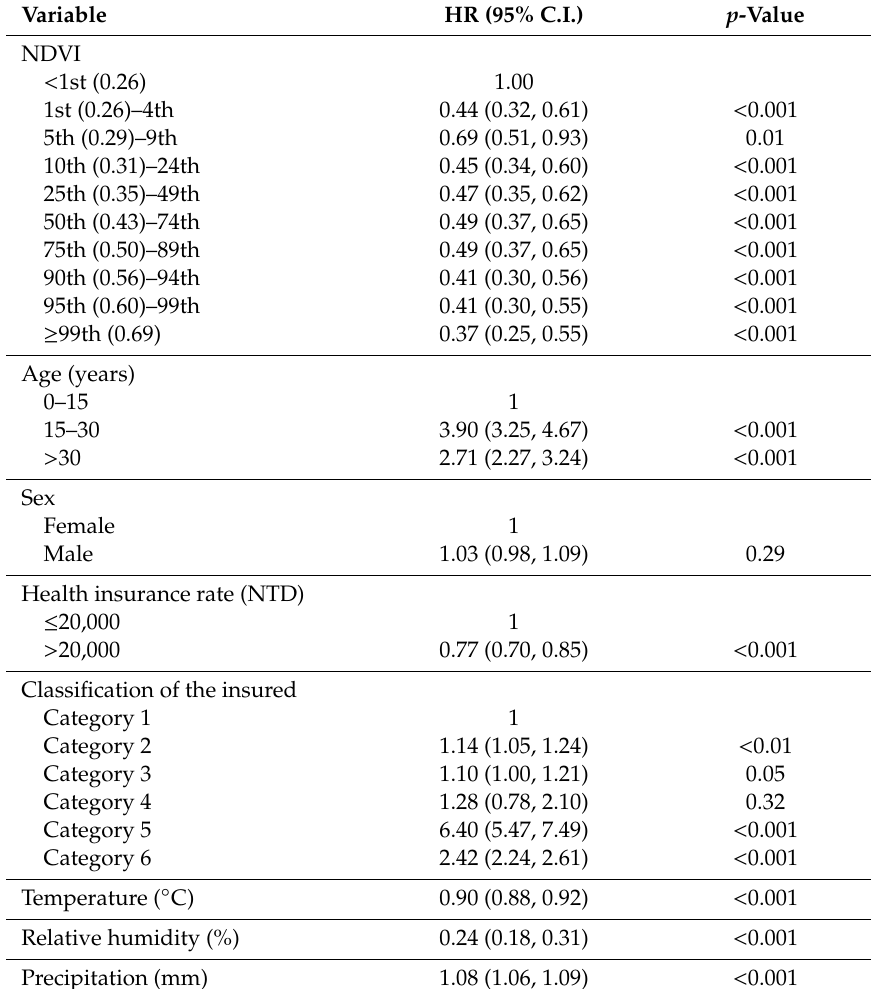
Table 2. Hazard ratios (HR) and confidence interval (C.I.) for categorical NDVI from 2000 m bu ff ers in cox